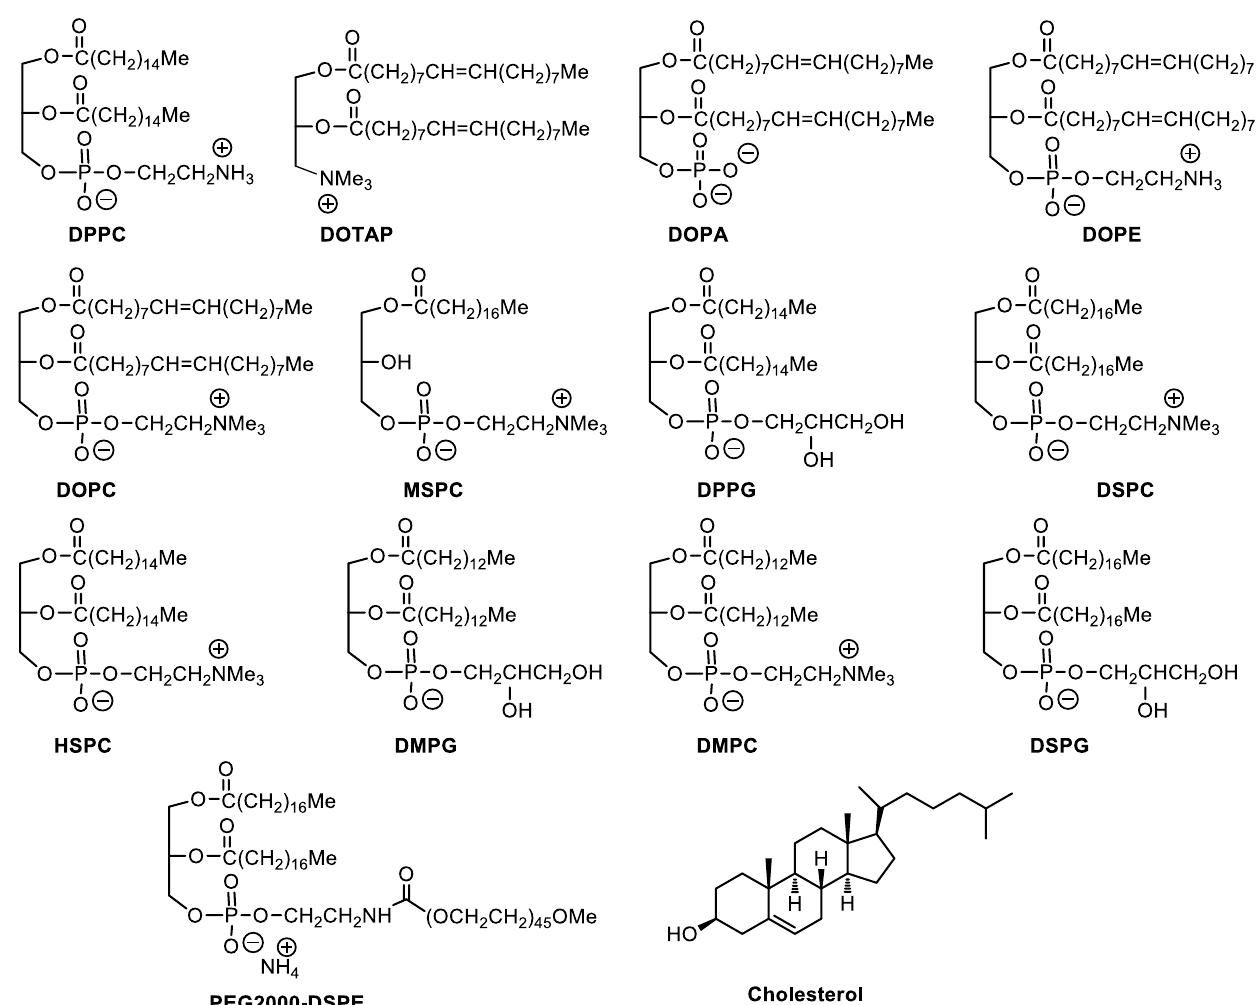
Figure 1. Chemical structures of most common lipids in liposome formulations including some from the recently approved Pfizer-BioNTech and Moderna SARS-CoV-2 liposomal vaccines. Abbreviations: DOTAP, 1,2-dioleoyl-3-trimethylammonium propane; DPPC, dipalmitoylphosphatidylcholine; DOPA, 1,2-Dioleoyl-sn-Glycero-3-Phosphate; MSPC, monostearoylphosphatidylcholine; DPPG, dipalmitoylphosphatidylglycerol; DSPC, distearoylphosphatidylcholine; HSPC, hydrogenated soy PC; DMPG, l- α -dimyristoylphosphatidylglycerol; DMPC, 1- α -dimyristoylphosphatidylcholine; DOPC, 1,2-Dioleoyl-sn-glycero-3-phosphocholine; DOPE, dioleoyl phosphatidylethanolamine; DSPG, distearoylphosphatidylglycerol; PEG2000-DSPE, polyethylene glycol 2000-distearoylphosphatidylethanolamine.